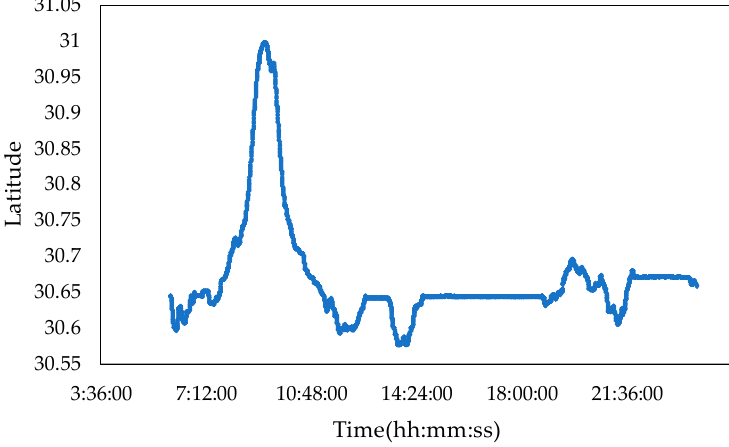
Figure 6. The time series graph of the latitudes of trajectory points of the shadowed taxi trajectory.